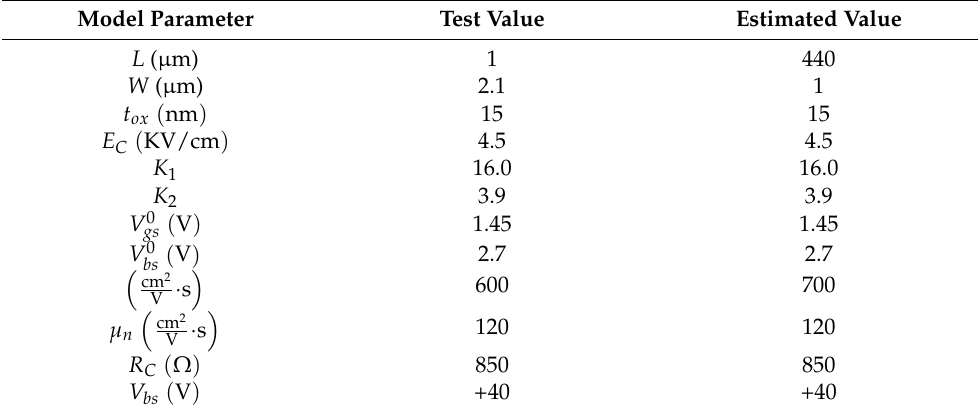
Table 1. Model parameters for bilayer graphene field effect transistor (FET).